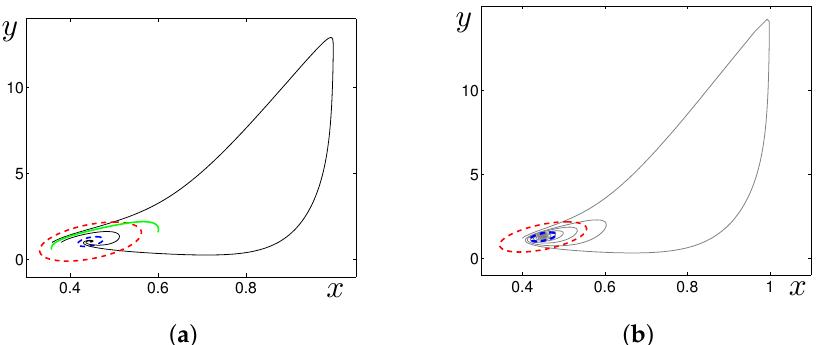
Figure 6. Confidence ellipses around the equilibrium M : ( a ) for D = 0.3 and noise intensities ε = 0.01 (blue), ε = 0.04 (red); ( b ) for D = 0.248 and noise intensities ε = 0.003 (blue), ε = 0.01 (red). Here, fiducial probability P =